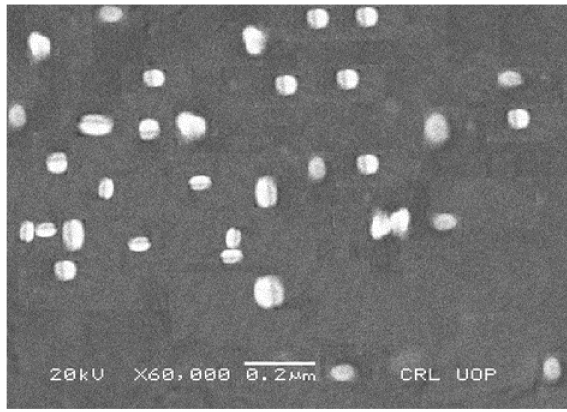
Figure 4. SEM micrograph of NOR-5 formulation.